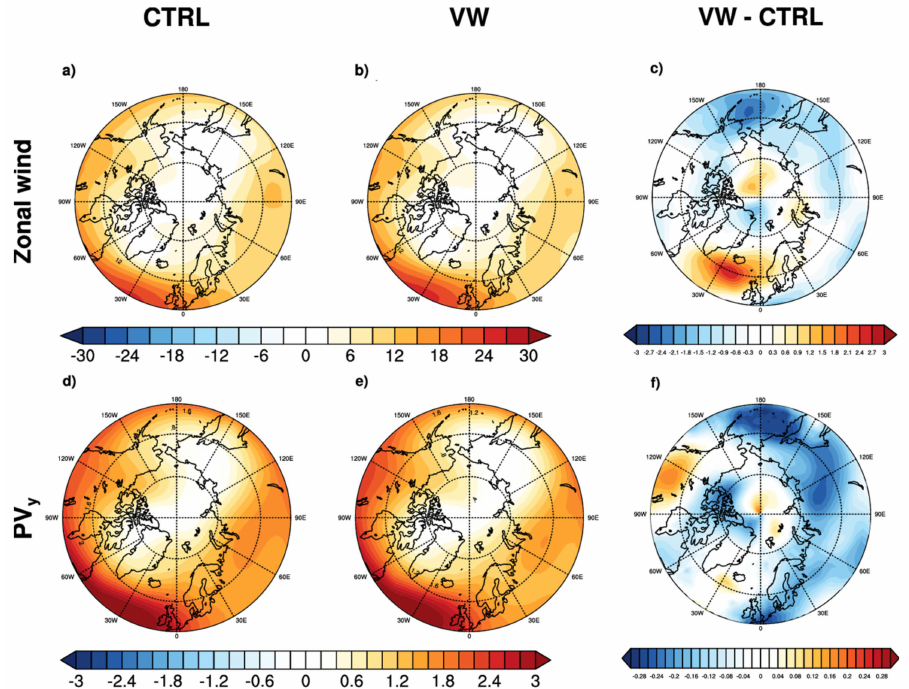
Figure 6. DJF-mean 500 hPa Zonal winds (ms − 1 ; ( a – c )) and meridional potential vorticity gradient (10 − 6 Km 2 kg − 1 s − 1 ; ( d – f )) on the 315 K isentropic surface during winter without ural blocking days ±